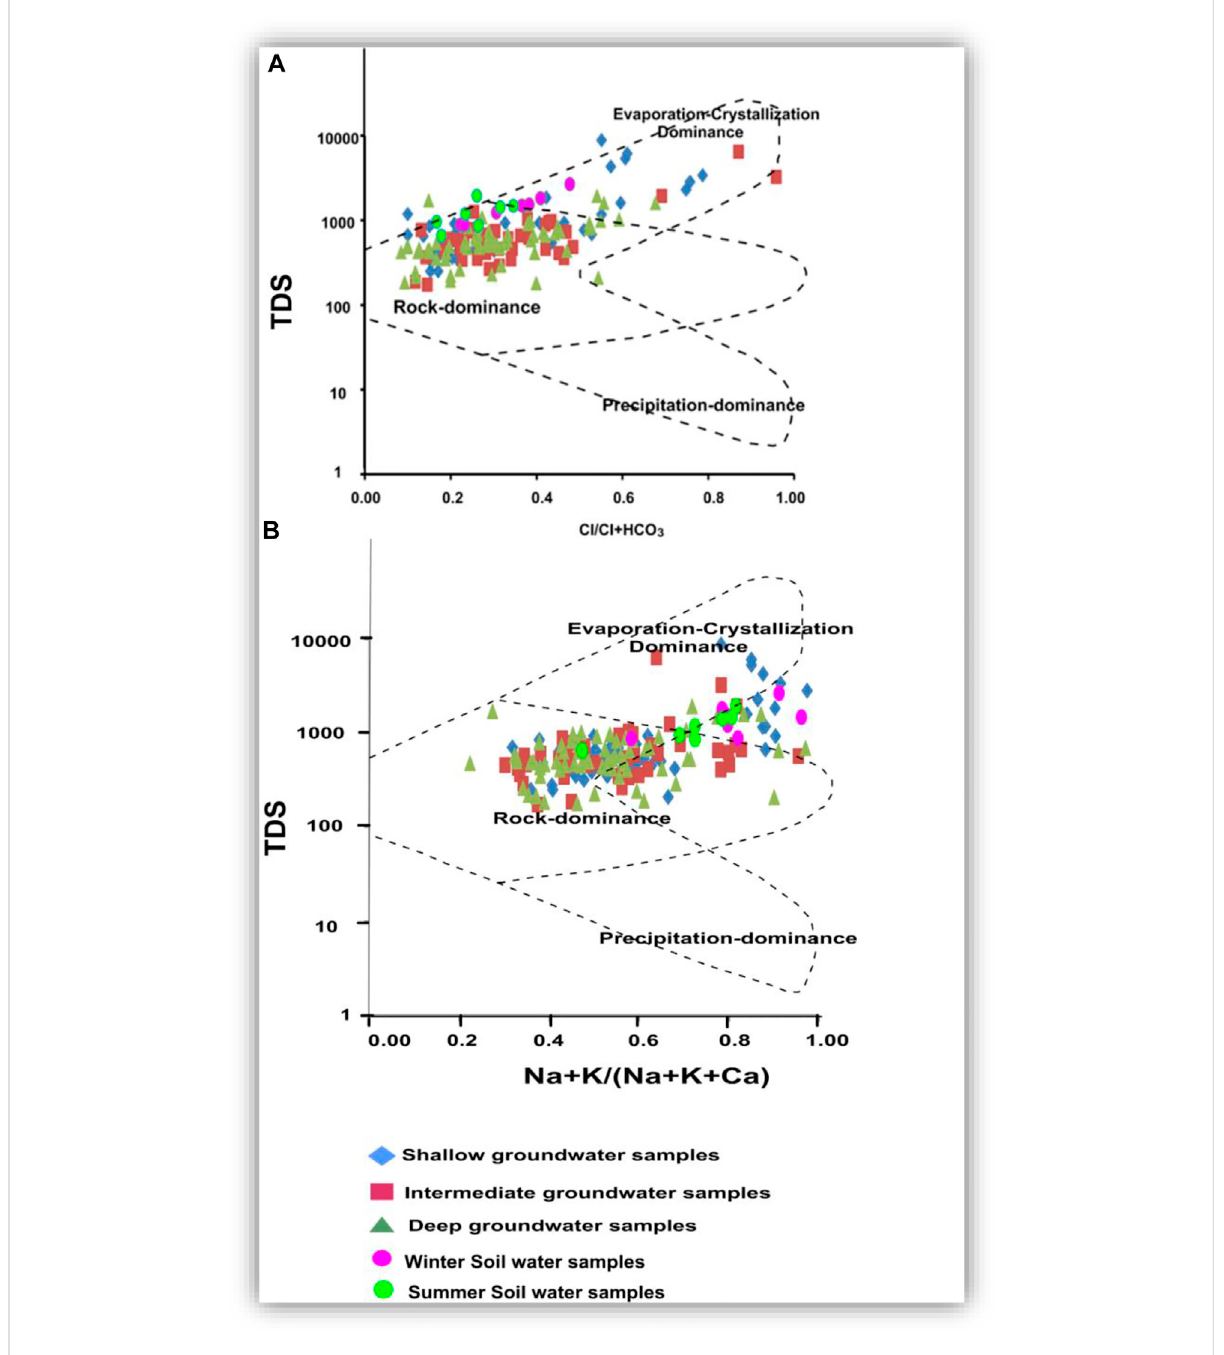
FIGURE 16 Gibbsdiagrams (A,B)